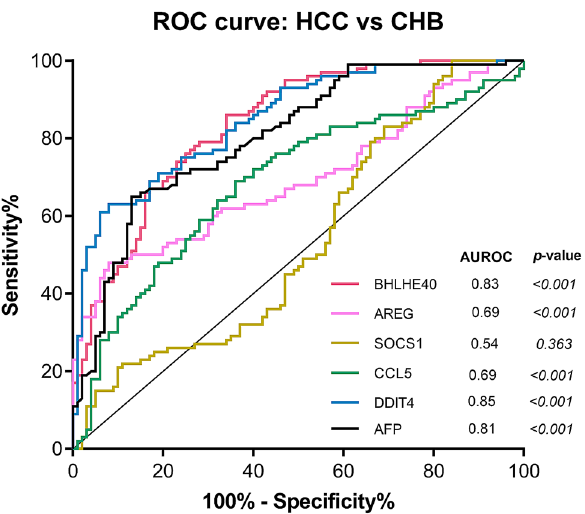
Figure 3. Relative expression of candidate cancer-induced genes in PBMCs of patients with HBV-HCC, CHB and healthy controls. ( A ) BHLHE40, ( B ) AREG, ( C ) SOCS1, ( D ) CCL5 and ( E ) DDIT4. Relative expression of genes represents as log 2 on y-axis.